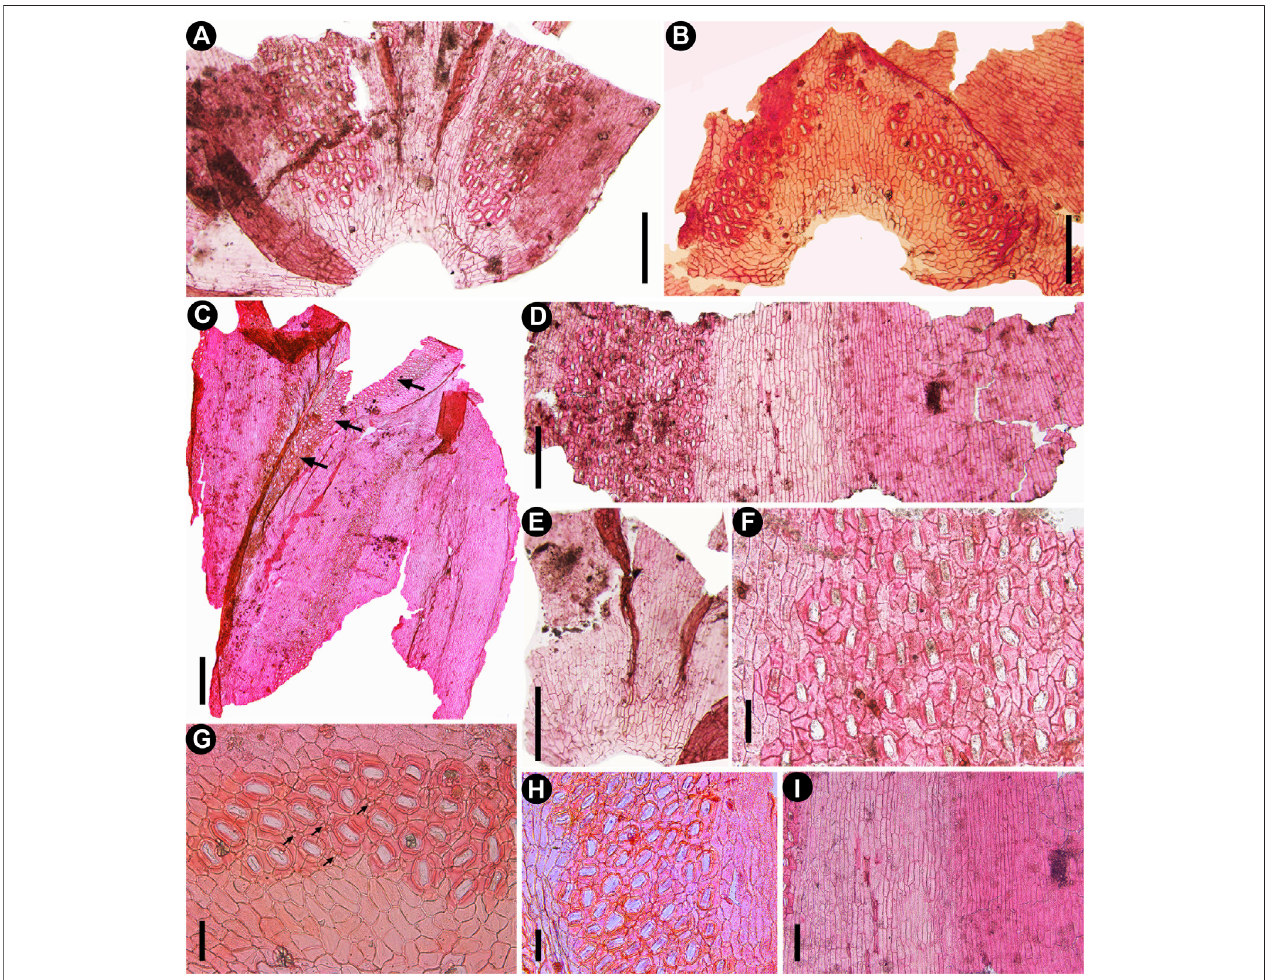
FIGURE 4 | Cuticular characters of fossil Fokienia tianpingensis sp. nov., LM. (A) Cuticle of facial and two lateral leaves showing the distribution of stomatal bands ontheundersideofabranchlet,TX-63 – 2. (B) Stomataldistribution ontheadaxialsurfaceofafacialleafoftheshootunderside,TX-63 – 2. (C) Thecuticleofonefacialand one lateral leaves (from left to right) showing stomatal distribution on the abaxial and adaxial (arrow) surfaces, TX-39. (D) Abaxial cuticle of a lateral leaf showing the nonstomatal surface on the upper side of the branchlet (right) and a broad stomatal band on the underside of the branchlet (left), TX-34 – 2. (E) Narrow stomatal zones along the sutures between facial and lateral leaves on the upper side of a branchlet, TX-63 – 2. (F) Enlargement of the stomatal band in (D) showing the stomatal density and shared subsidiary cells. (G) Enlargement of stomata in (B) showing papillae within the stomatal band (arrows). (H) Enlargement of the stomatal band on the undersideofthelateralleafin (C) . (I) Enlargementofnonstomatalzonesofthelateralleafin (D) ontheuppersideofbranchlet(right)andontheunderside(left).Scalebars for (A, B, D, E) (cid:1) 200 μ m, (F – H) (cid:1) 400 μ m, (I) (cid:1) 100 μ m.